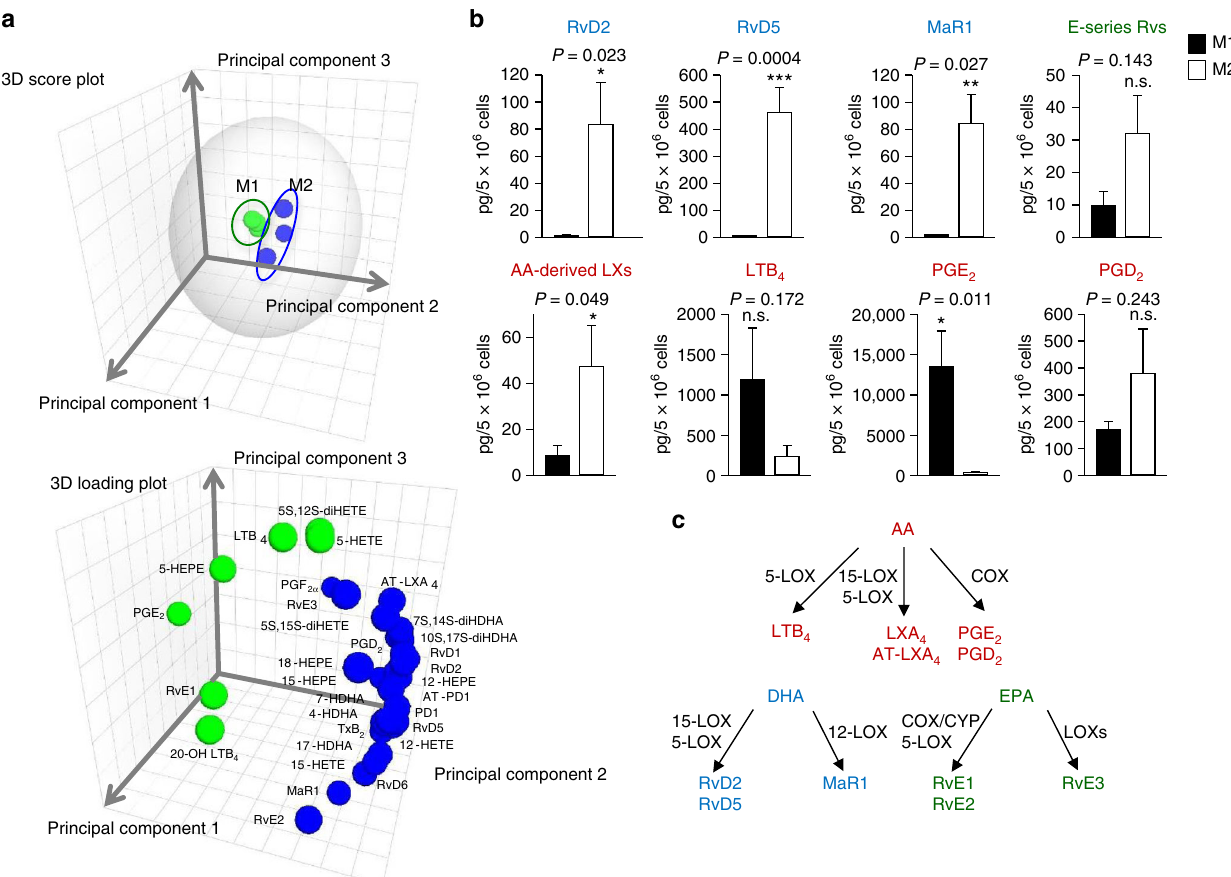
Fig. 2 M1 and M2 macrophages exposed to E. coli produce differential lipid mediators. Human M1 and M2 (5 × 10 6 cells/ml PBS + Ca/Mg) were incubated for 90 min with E. coli (O6:K2:H1; ratio, 1:50) at 37 °C. Lipid mediators were isolated by SPE and analyzed by LC – MS – MS. a PCA of the lipid mediator pro fi le (SPM, PG, LTB 4 ) of M1 and M2. Upper panel: 3D score plot; lower panel: 3D loading plot. b Selected values of lipid mediators formed by M1 and M2 exposed to E. coli . Data are given as means ± S.E.M, n = 7 (RvD2, RvD5, MaR1, AA-derived LX, LTB 4 , PGD 2 , PGE 2 ), n = 5 separate donors